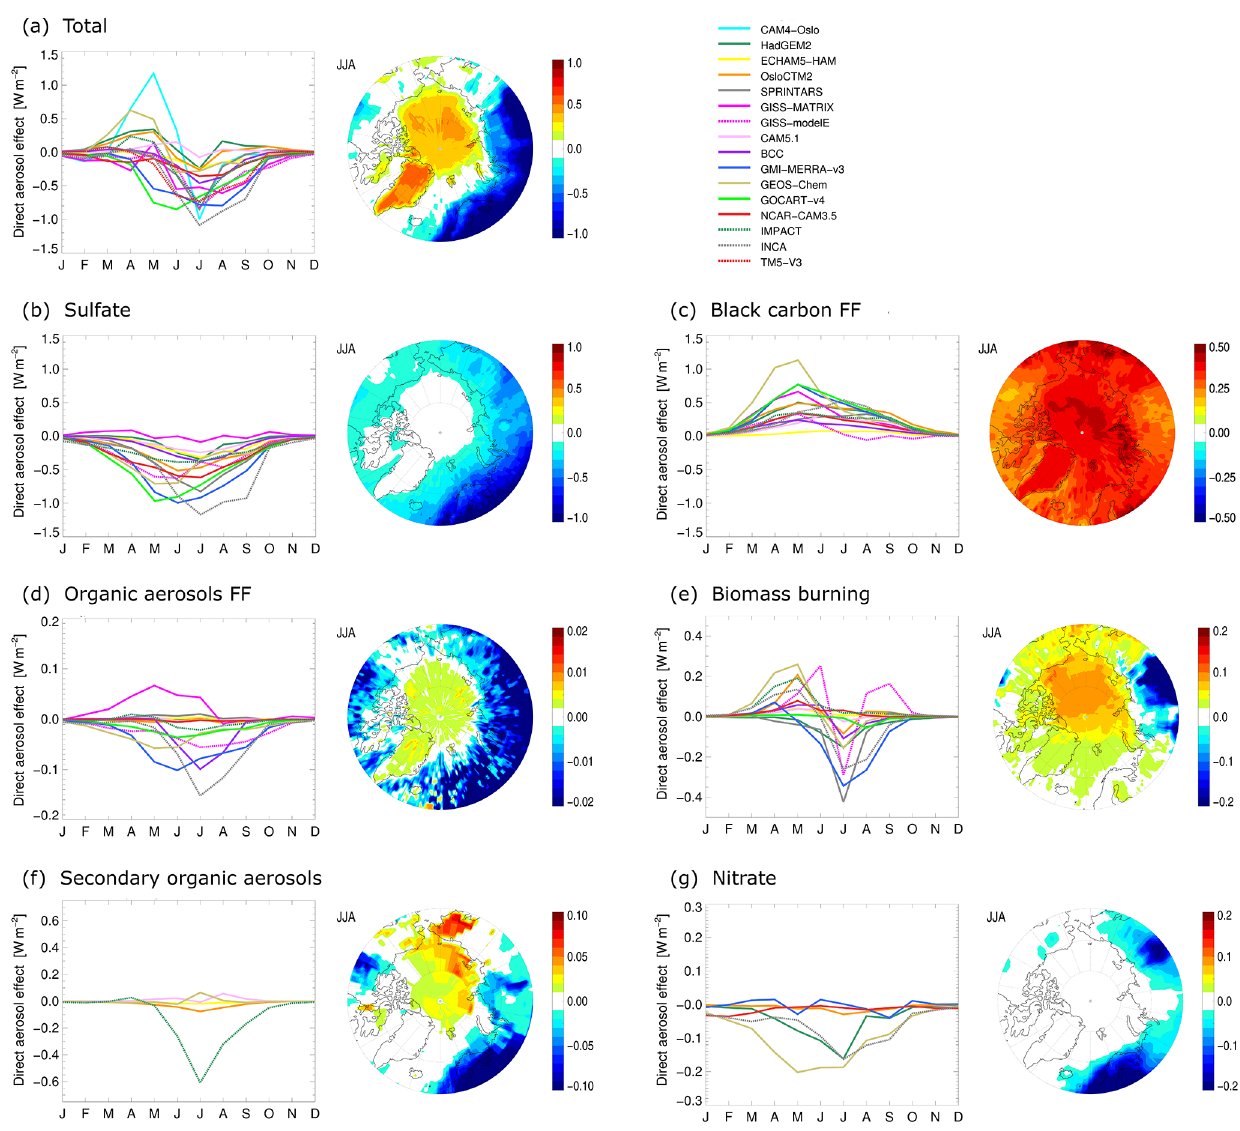
Figure 13. Arctic mean DAE seasonal cycle and the summer (JJA) mean model-media n geographical distribution of (a) total aerosol, (b) sulfate, (c) BC FF, (d) OA FF, (e) BB, (f) SOA, and (g) nitrate. Note the different axes.